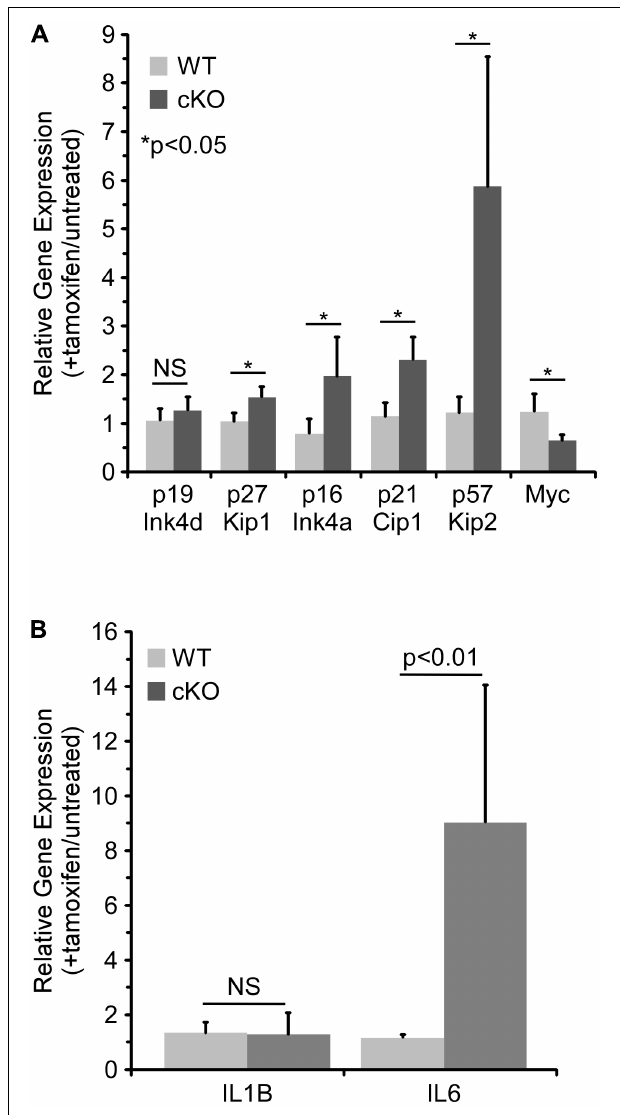
FIGURE 4 | NKAP deficiency in hematopoietic progenitor cultures leads to upregulation of genes associated with cell cycle arrest and senescence. Hematopoietic progenitor cells as described in Figure 2 were either treated with tamoxifen for four days or left untreated. RNA was obtained from the cells and expression of the indicated genes determined by RT-PCR using Taqman gene expression assays (see section “Materials and Methods”). The data shown is averaged from four independent experiments initiated from separate pairs of mice. Gene expression relative to a normalizer was first calculated for each cDNA sample, and then the ratio of gene expression in tamoxifen treated cells relative to untreated cells of the same genotype determined. Note that for the WT cells, the data does not indicate any significant change upon tamoxifen treatment (relative expression of 1.0). (A) Expression of cell cycle regulators. (B) Expression of senescence associated